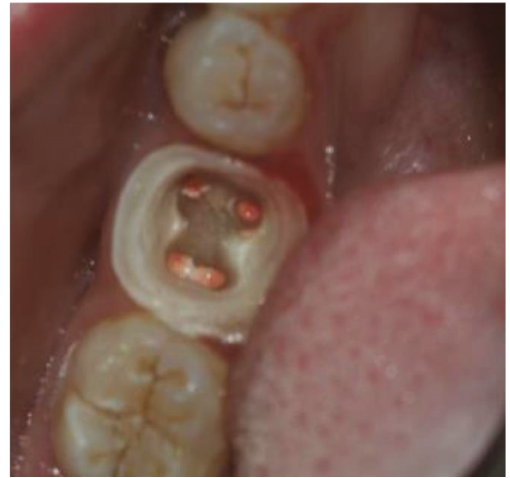
Figure 4: Removing Gutta-percha to a depth not exceeding